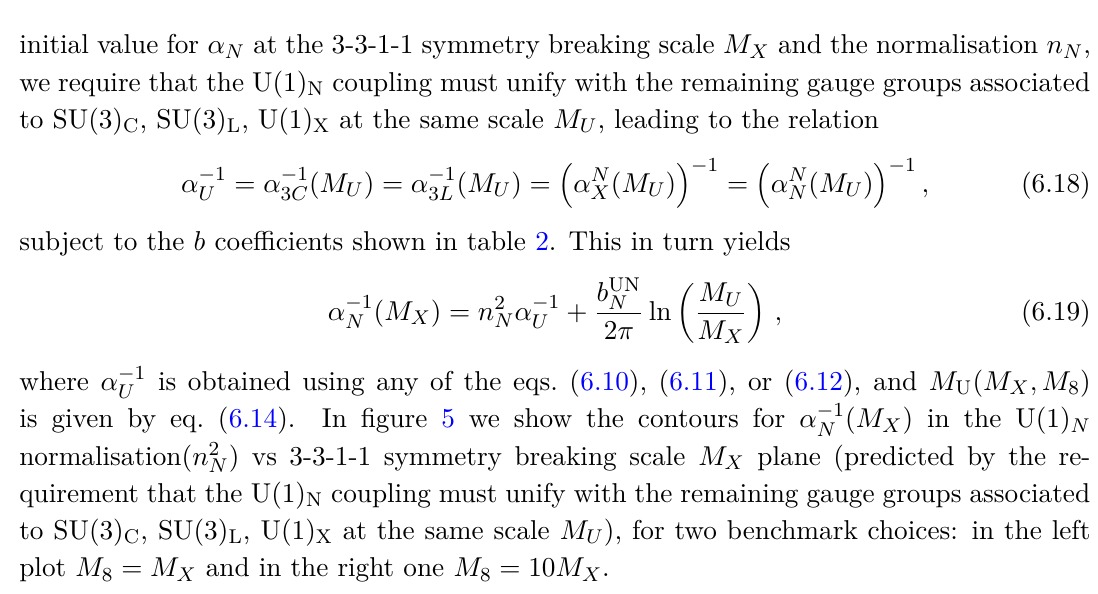
= 10 TeV and M = 3 M = 30 TeV, corresponding X 8 X